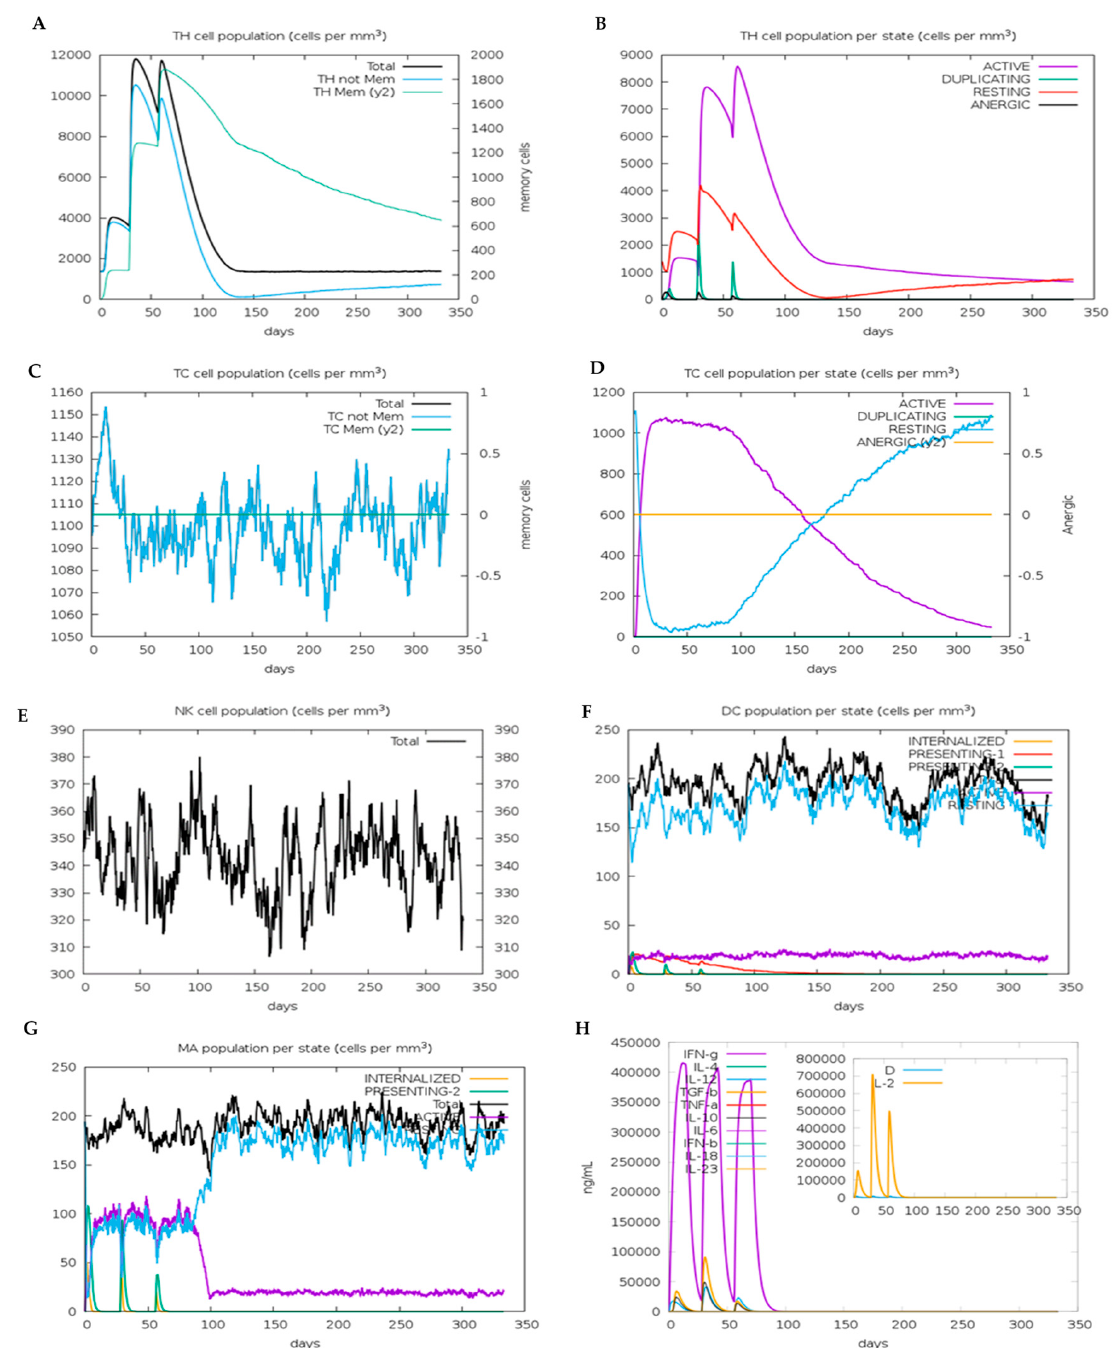
Figure 7. The immune simulation analysis of the VC: ( A ) Population of HTL. ( B ) The population of different states of HTL. ( C ) population of CTL. ( D ) Population of different states of CTL. ( E ) Population of NK cells. ( F ) Population of different states of dendritic cells. ( G ) Population of different states of macrophages. ( H ) Level of cytokines and interleukins produced in responses to vaccine.